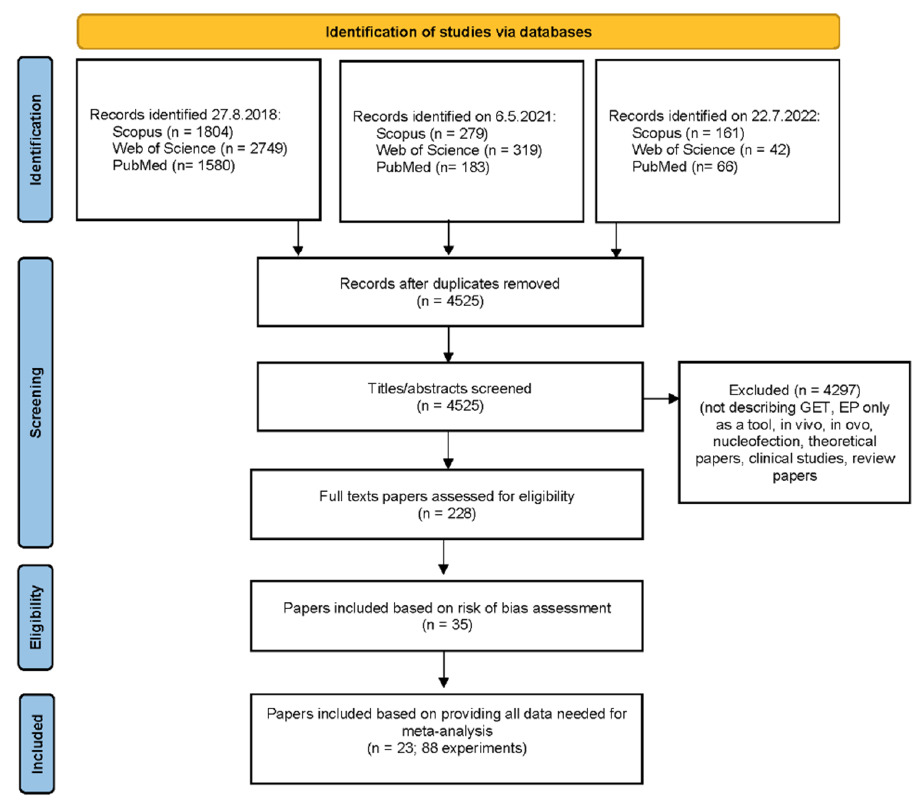
Figure 2. PRISMA flow diagram of paper selection.